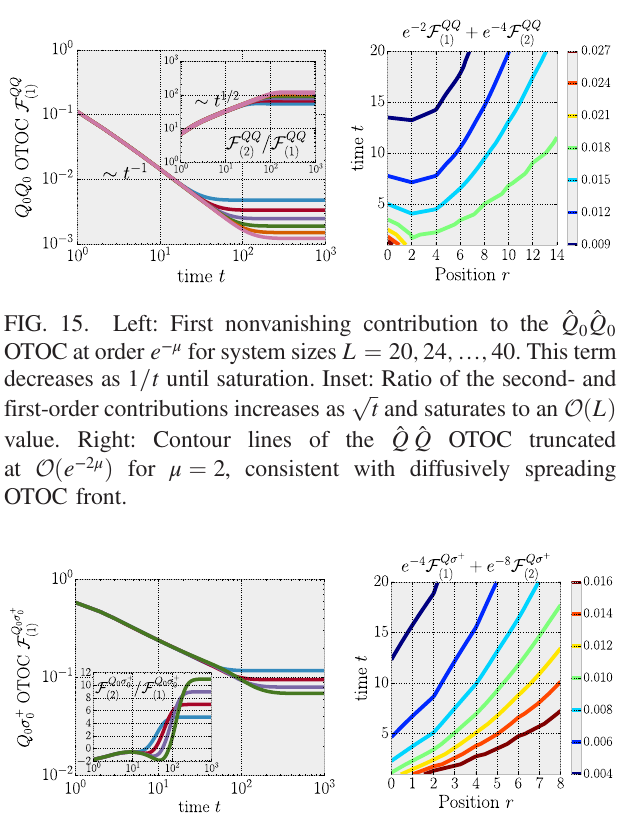
ˆ Q ˆ σ þ 0 0 ˆ Q ˆ σ þ OTOC truncated at